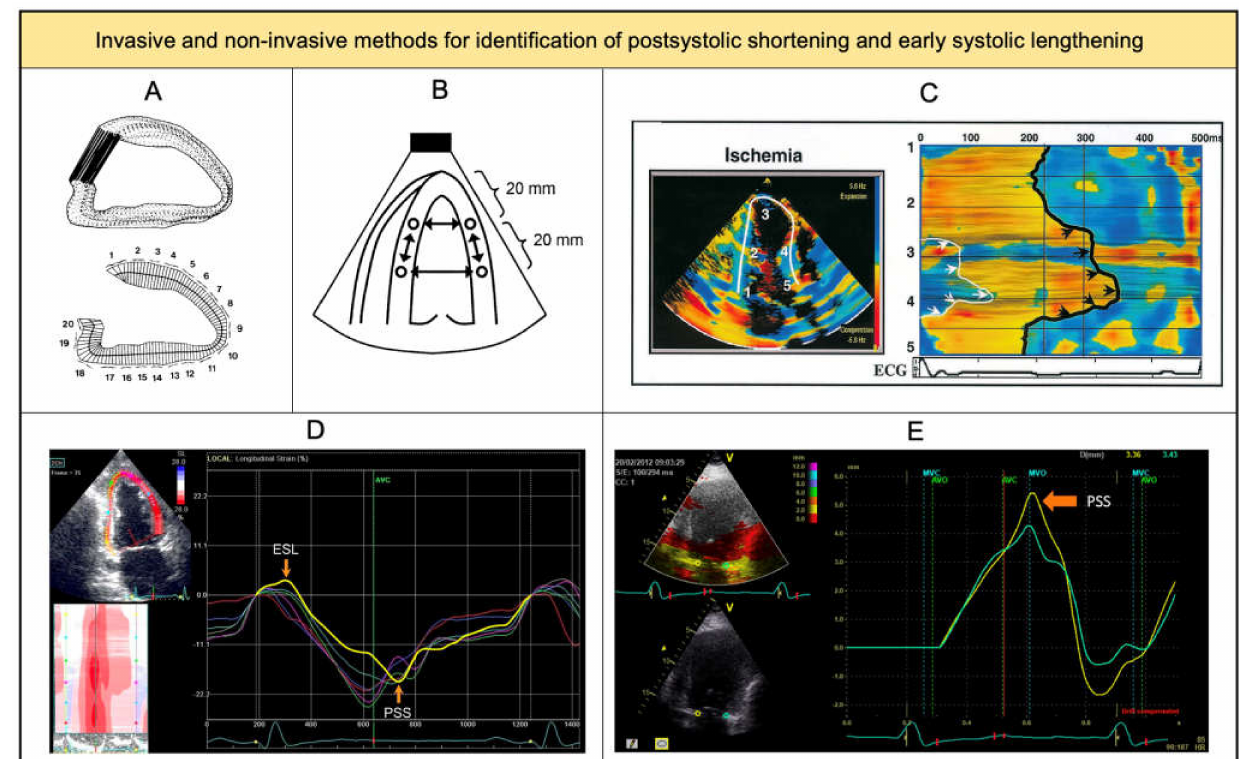
Figure 2. Invasive and non-invasive methods for assessing deformation patterns. Legend: ( A ) Ventriculogram depicting the centerline method for assessing wall motion. ( B ) Circles in the myocardial walls indicate embedded ultrasonic crystals to determine segmental length during the cardiac cycle. ( C ) Strain rate map during ischemia, where black arrows indicate postsystolic shortening and white arrows indicate delayed systolic shortening. ( D ) Longitudinal speckle tracking profile showing early systolic lengthening and postsystolic shortening. ( E ) Tissue Doppler imaging of longitudinal displacement of the mitral valve annulus showing postsystolic shortening. ( A – C ) are reprinted from Hosokawa et al. [14], Amundsen et al. [15] and Pislaru et al. [16] with permission the American College of Cardiology (Elsevier). ( D ) is reprinted from Asanuma et al. [6] with permission from the British Medical Journal Publishing Group. ( E ) is reprinted from Brainin et al. [17] with permission from Springer